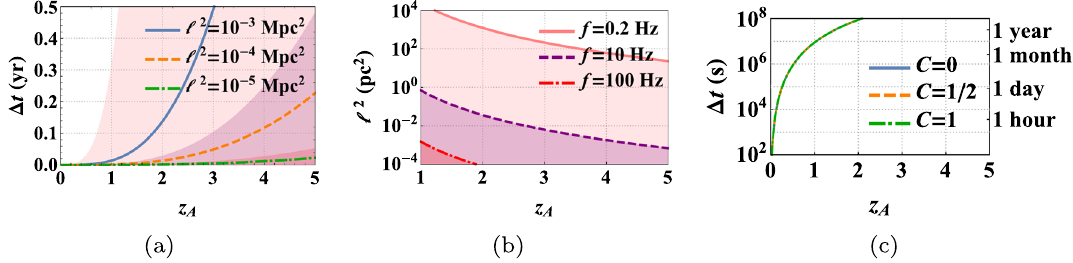
Fig. 4 The time delay and allowed AdS 6 radius based on the DECIGO/BBO. a The predicted time delay with respect to the source redshift. The AdS 6 radius is set as (cid:2) 2 = 10 − 3 Mpc 2 (blue solid curve), (cid:2) 2 = 10 − 4 Mpc 2 (orange dashed curve), and (cid:2) 2 = 10 − 5 Mpc 2 (green dashed and dotted curve). b The allowed AdS 6 radius with respect to the source redshift. The observed GW frequency is set to f = 0 . 2Hz